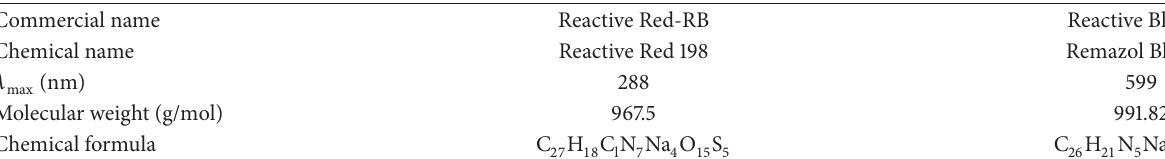
Table 2: General properties of reactive dyes.